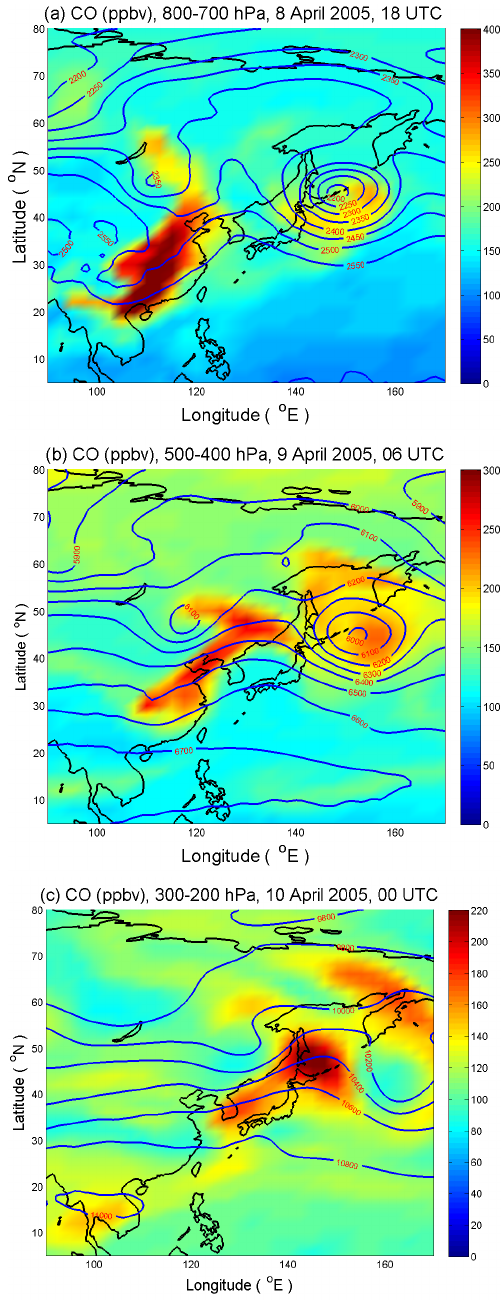
Figure 14. The GEOS-Chem simulated CO (a) on 8 April 2005 in the lower troposphere (800–700hPa), (b) on 9 April in the middle troposphere (500–400 hPa), and (c) on 10 April in the upper tropo- sphere (300–200hPa). The contours are the geopotential height at 850, 450, and 250hPa,